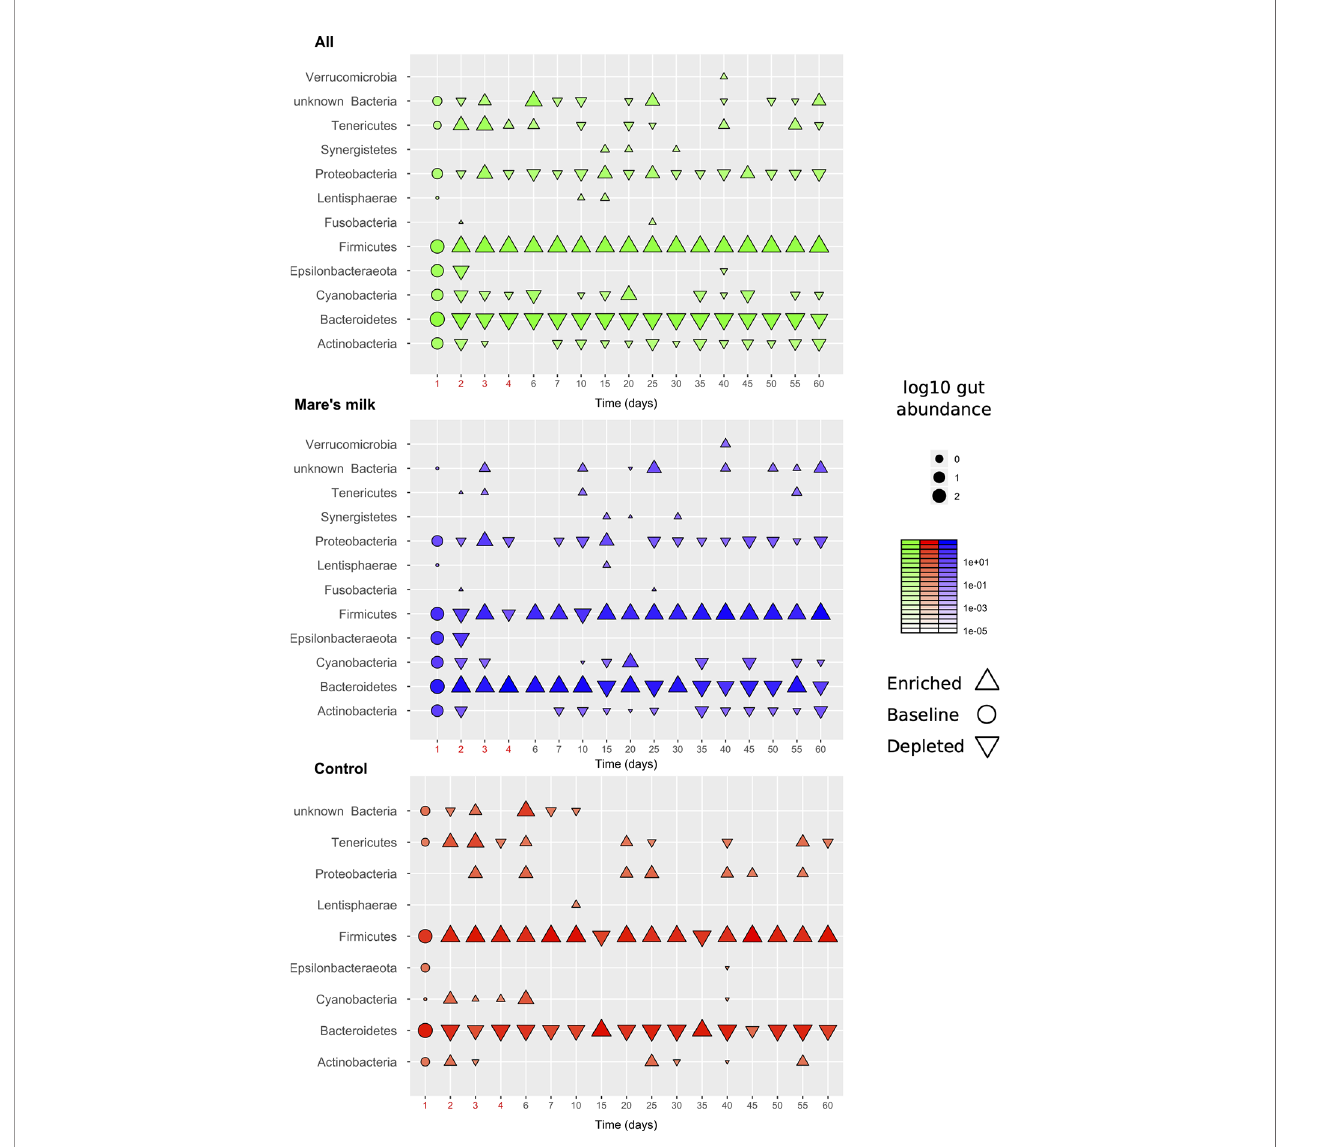
FIGURE 3 | Overview of gut composition shifts at phylum level. The diagram shows gut abundance of different bacterial phyla, on average across the cohort (N=6, top panel), the intervention samples (N=3, middle panel), and the control samples (N=3, bottom panel). Marker size and intensity show average gut abundances with direction (upwards-facing: enriched, downwards-facing: depleted) compared to baseline (round markers). Most trends under the intervention (antibiotics: fi rst 5 days; mare ’ s milk: all 60 days) are seen in both groups but with exceptions. Various taxa are gained or lost below detection threshold during the observation